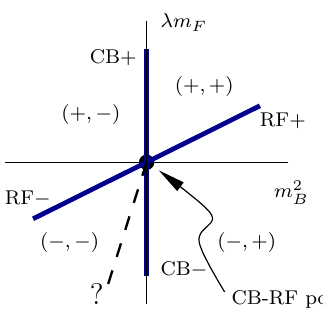
Figure 14. The neighbourhood of the CB-RF conformal point (thick dot at the origin) along with the putative phase transition line (dashed line) where the classical mass of the singlet fermions goes to zero. The various labels are the same as in (cid:12)gure 14. The dashed phase transition line arises from O ( N 0 ) e(cid:11)ects that have not yet been computed as explained in section 4.4.4 and we have placed a question mark near the line to re(cid:13)ect this lack of quantitative information.